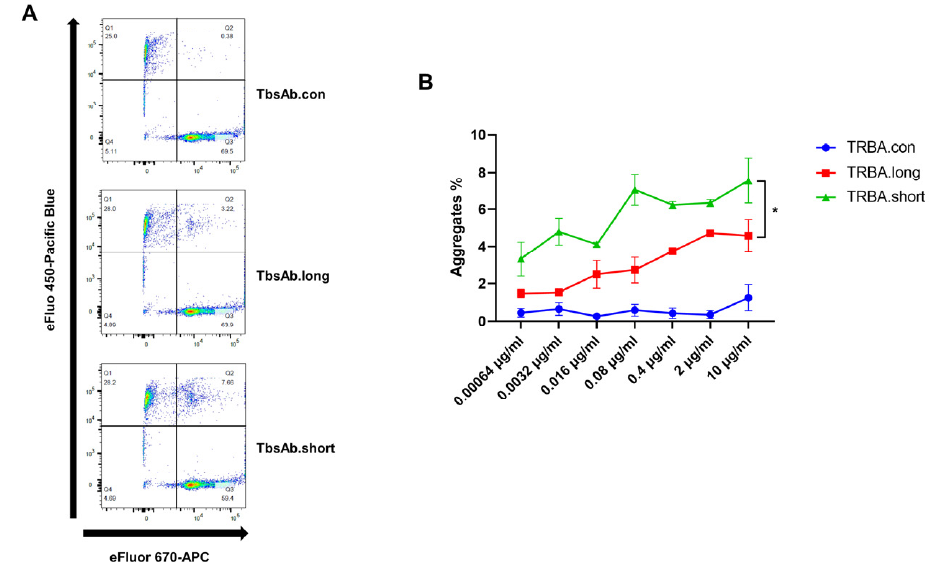
Figure 5. The TbsAb.short form shows better cell aggregate formation than the TbsAb.long form. OT-1 cells were labeled with eFlour 670 dye, and ID8 cells were labeled with the eFlour 450 dye. ( A ) Cells were incubated for 30 min at room temperature with TbsAb.con, TbsAb.long or TbsAb.short molecules at 0.672 nM (0.08 µg/mL). The OT-1-ID8 cell-cell association was determined using flow cytometry and quantified as the percentage of eFlour 450 and eFlour 670 double positive cells in the upper right quadrant. ( B ) The experiment was repeated using increasing concentrations for each of the molecules. Each experimental point was set up in duplicate and the mean SD was plotted. *: p < 0.05.